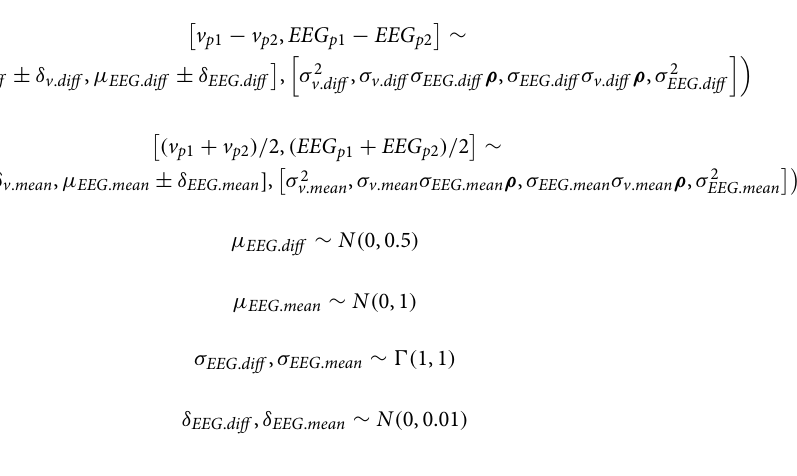
the v.mean parameter and the average of the EEG measure over difficulty levels (EEG.mean) , and between the v.diff parameter and the difference in the EEG measure between difficulty levels (EEG.diff) . This meant that the structure of the original hierarchical model (with age partialled out) only differed for the drift-rate parameter, which was now a bivariate normal with the EEG measure: